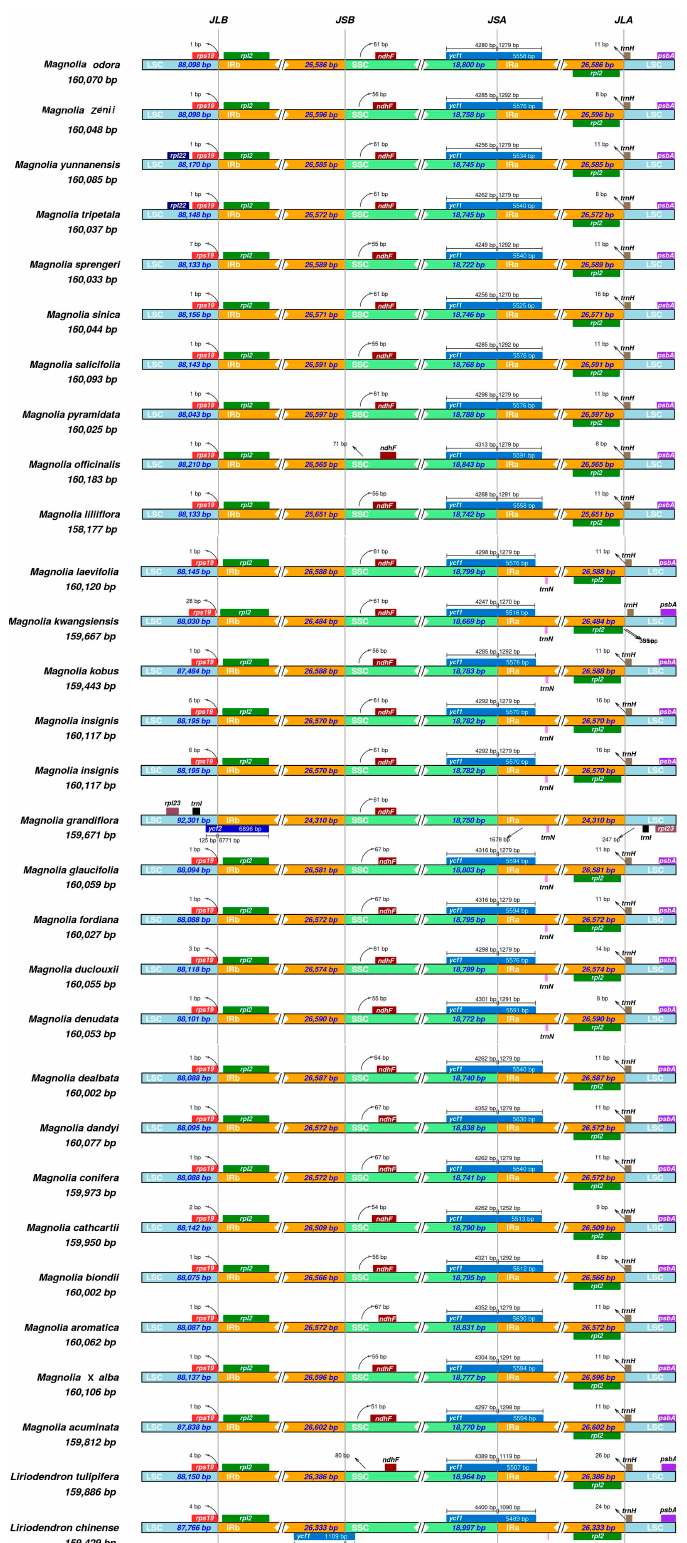
Figure 3. Comparison of the large single-copy (LSC), short single-copy (SSC), and inverted repeat (IR) regions in plastomes of 27 Magnolia (represented by 28 individual genomes including two M. insignis genomes) and two Liriodendron species. Genes are denoted by colored boxes. The gaps between the genes and the boundaries are indicated by the base lengths (bp).